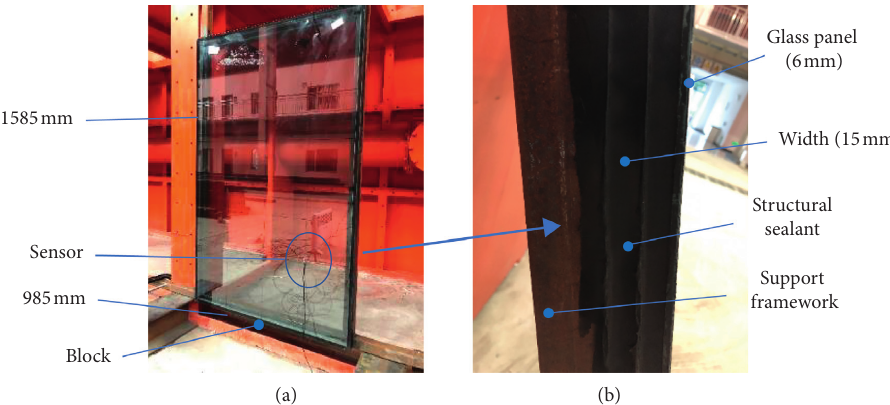
Figure 4: Experimental sample. (a) Overall sample; (b) local